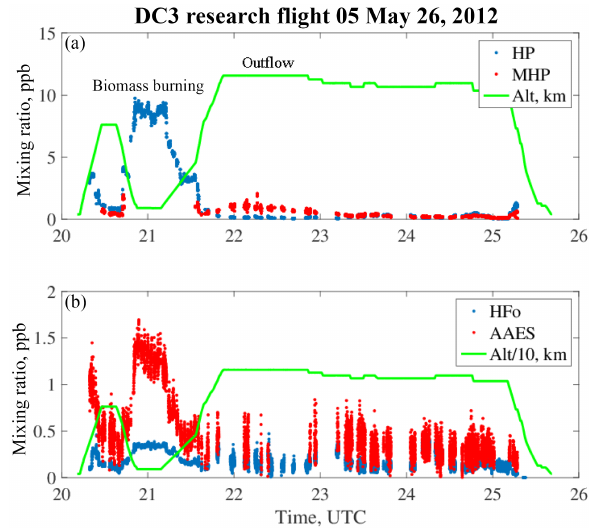
Figure 7. PCIMS DC3 Research Flight 5 (26 May 2012) sam- pling aged outflow from a Texas–Oklahoma storm. (a) Mixing ra- tios of HP (blue) and MHP (red) are shown in ppb as a function of flight time. (b) Mixing ratios of HFo (blue) and AAES (red) are shown in ppb as a function of flight time. The HIAPER altitude (green line) is in kilometers (kilometers/10 for b ). The periods of biomass burning and outflow are indicated. MHP is not reported during the low-altitude leg due to potential interferences at mass 80 ( H 2 O ) with an 18 O and NO − ( H 2 O ) from CO − 3 3